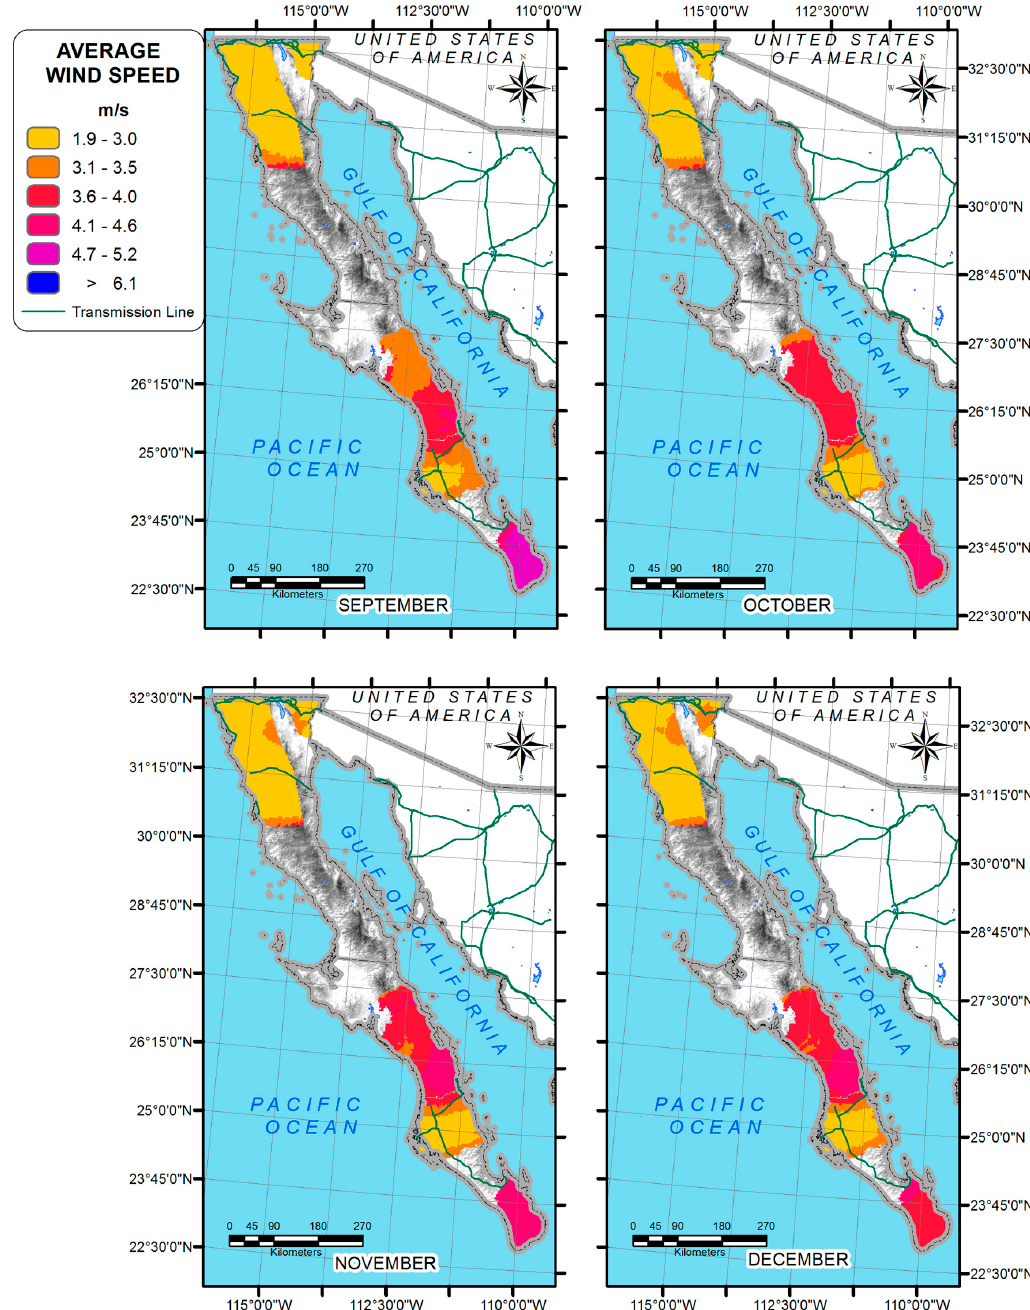
Figure 10. Average wind speed from September to December.